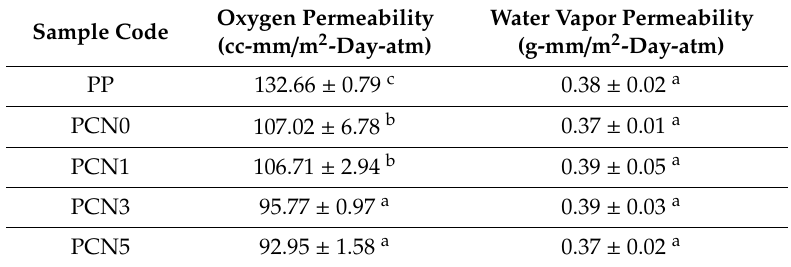
Table 5. Oxygen and water vapor permeability of PP and the PP / CNF and PP / CNF / nanoclay